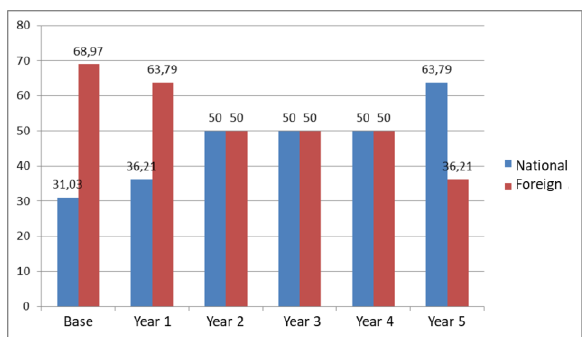
Fig. 8. Distribution by components at 5 years